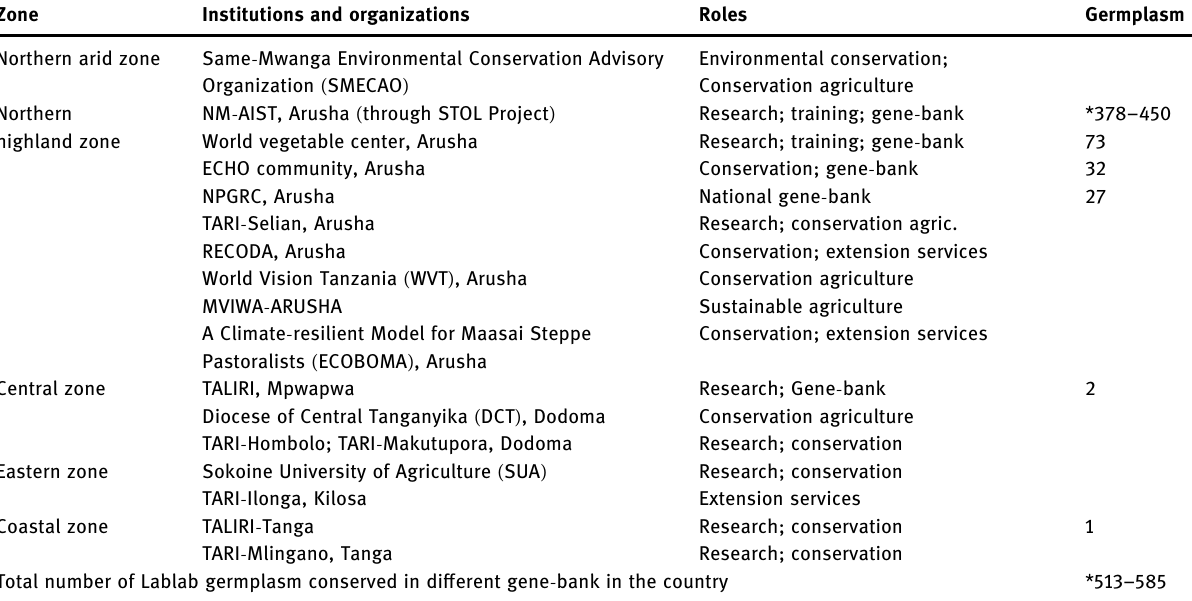
Table 2: Di ff erent sectors on Lablab crop improvement across the zones Zone